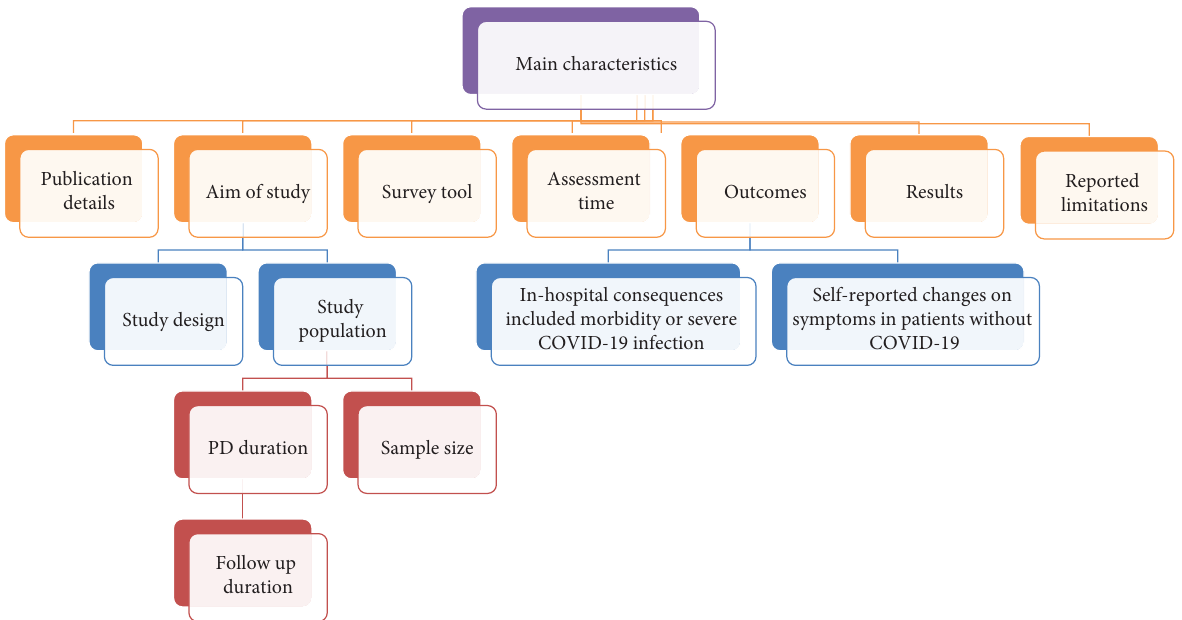
Figure 2: Main characteristics of the included